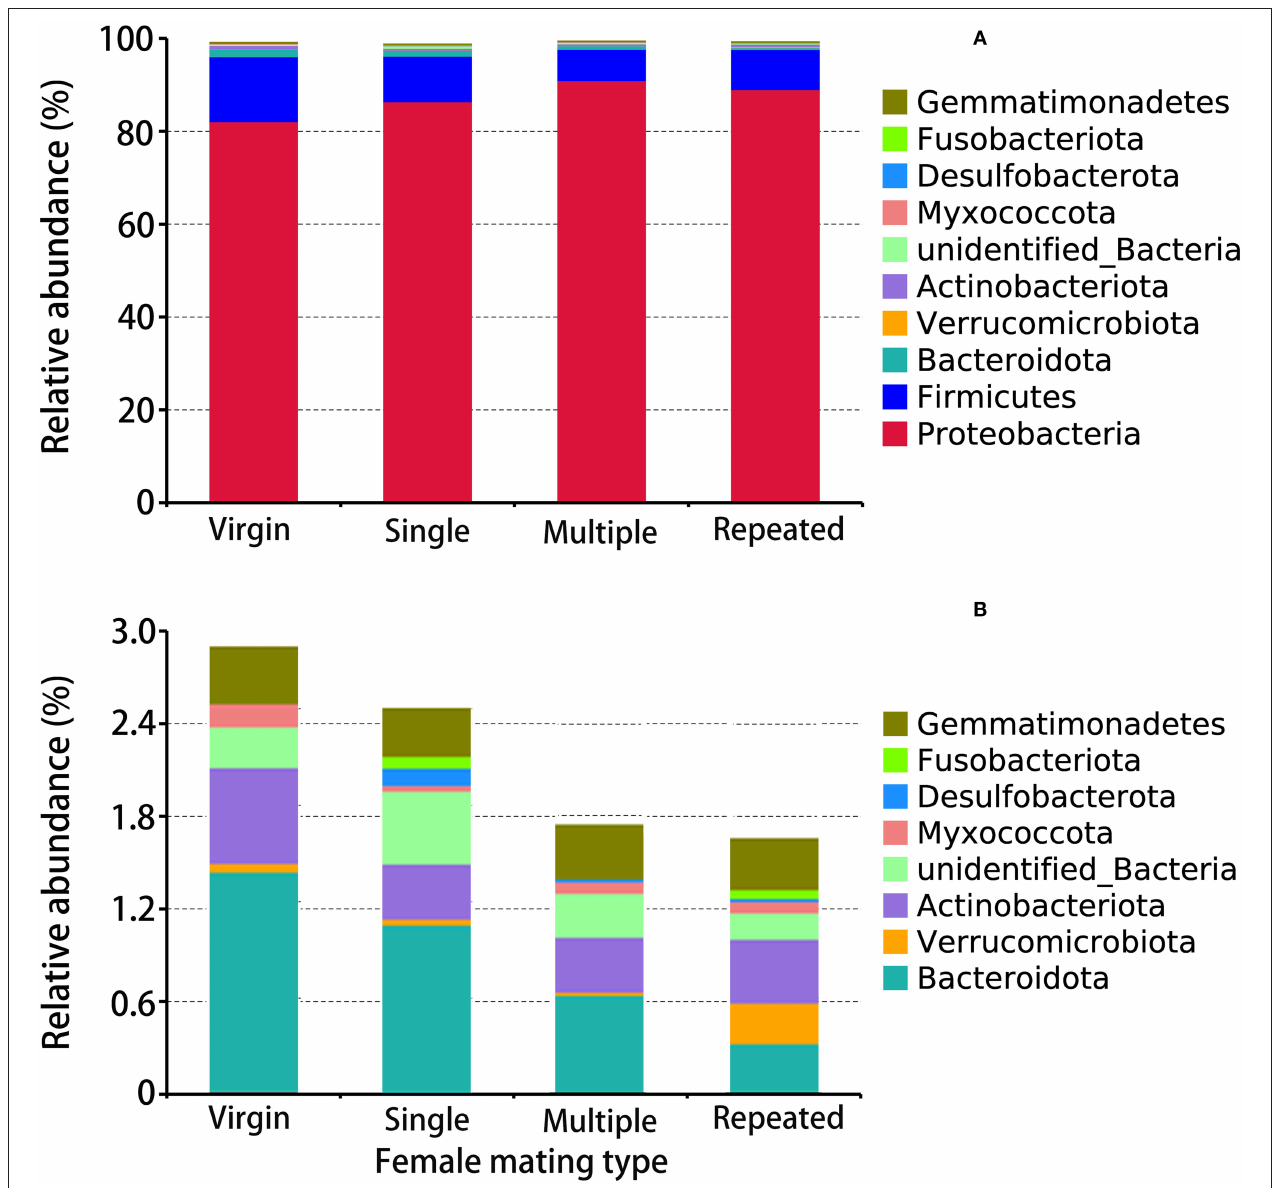
FIGURE 3 | Taxonomy assignment of bacterial OTUs at the phylum level in S. frugiperda females of different mating types. (A) The abundance pattern of the top 10 phyla. (B) A clearer display of the relative abundance of the 3rd to the 10th phylum.